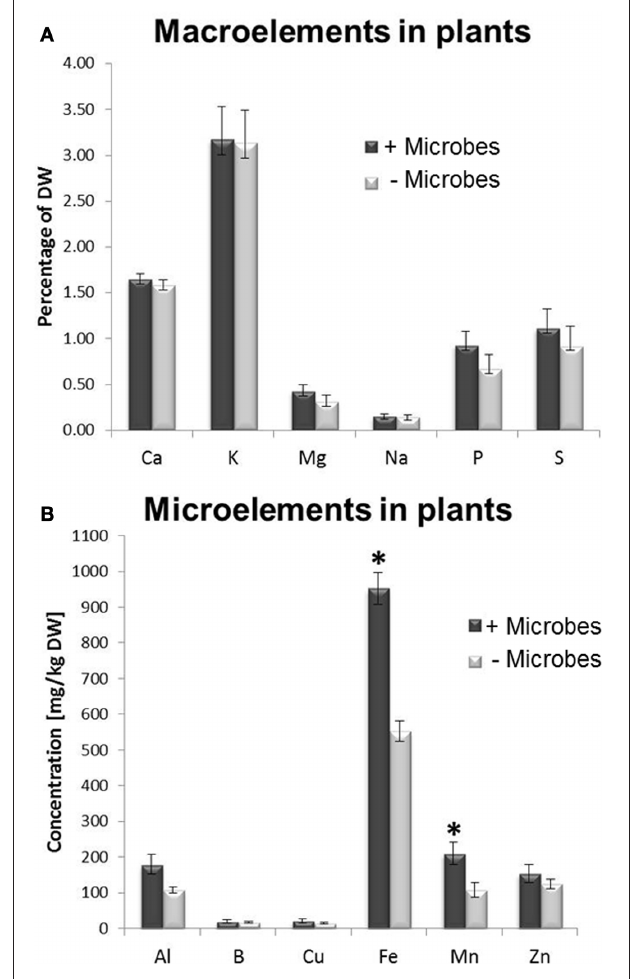
FIGURE 2 | Macro and micronutrient element analysis in Arabidopsis plants grown in the presence of soil microbes (non-sterile) or in microbe-free soils (sterile treatment). (A) Macronutrients, (B) Micronutrients. Bars represent mean values per dry weight (DW) ± SE from three biological replicates (20 pooled plants/replicate). The asterisk indicates a statistically significant difference ( P < 0 .